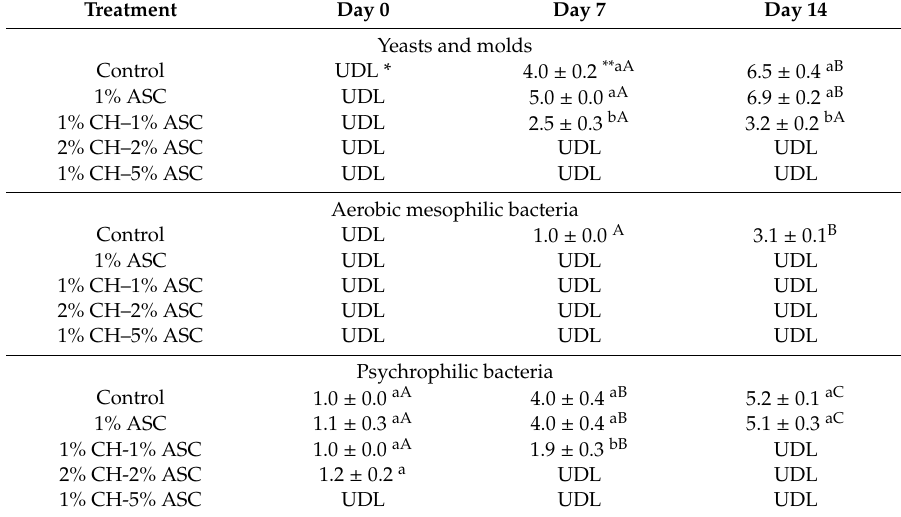
Table 4. Changes in the counts of yeasts and molds, aerobic mesophilic bacteria and psychrophilic bacteria (log 10 CFU / g) in fresh-cut apples during storage at 5 ◦ C